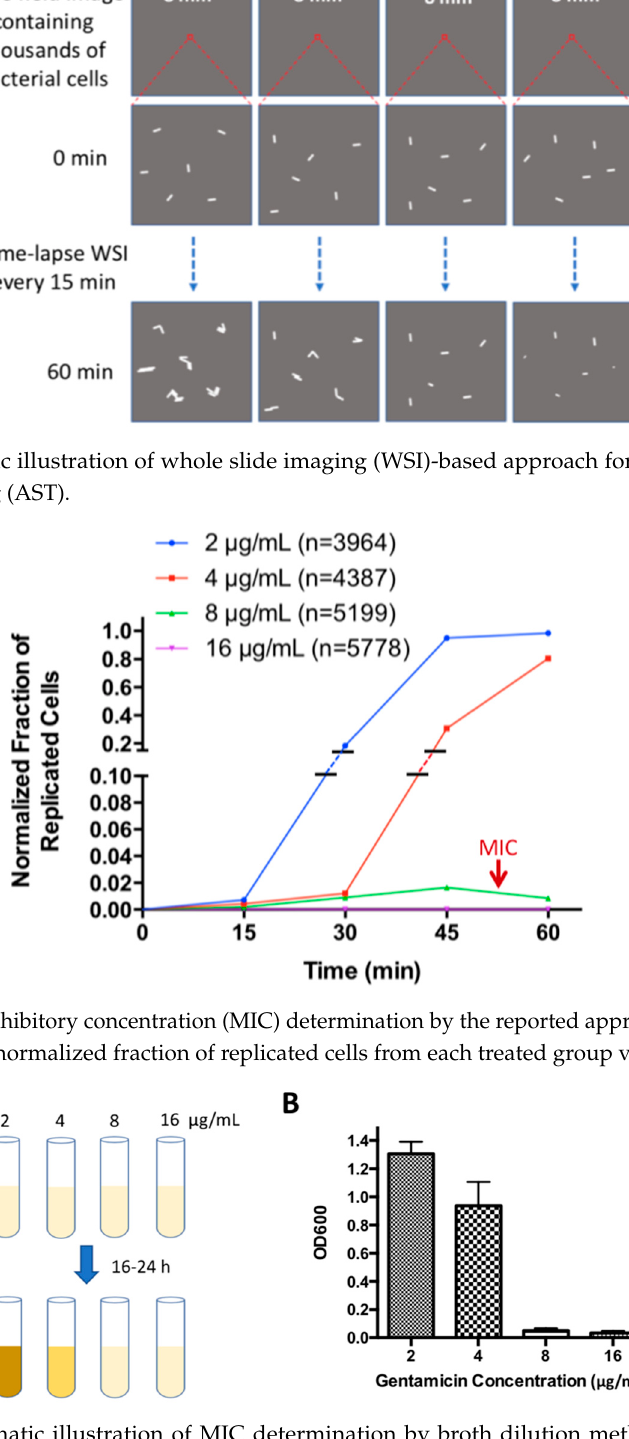
Figure 4. ( A ) Schematic illustration of MIC determination by broth dilution method. ( B ) OD600 obtained after the bacteria were incubated for 16 h.